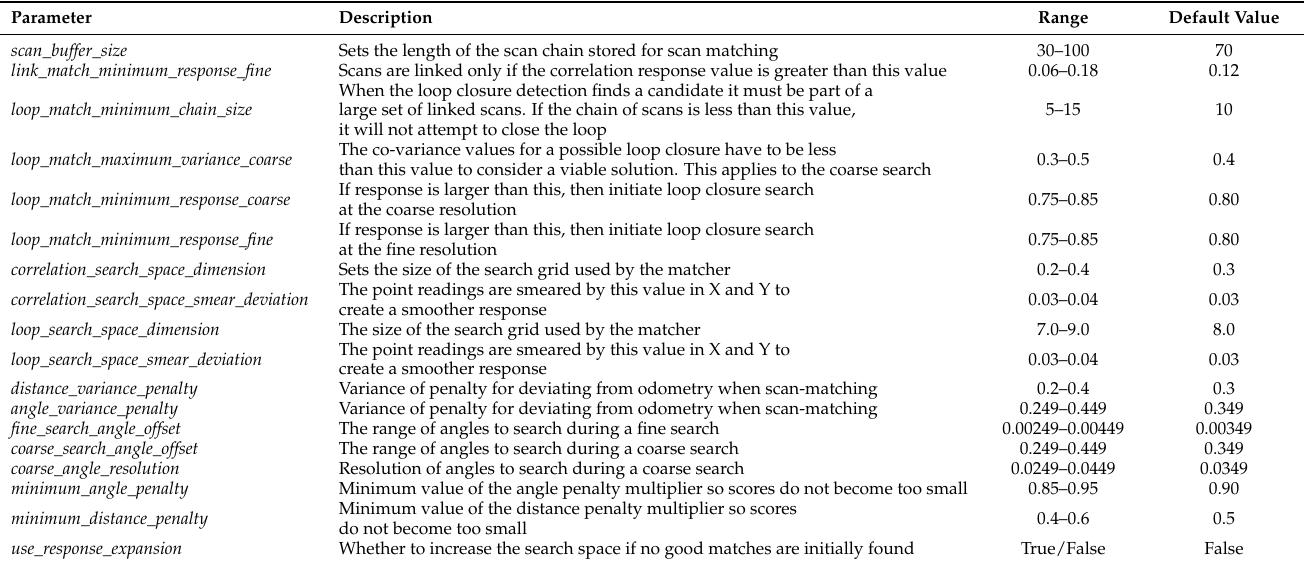
Table 4. List of KARTO-SLAM